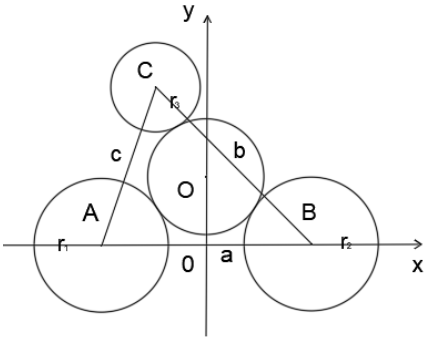
Figure 1. Determining the specific location of the node to be patched.